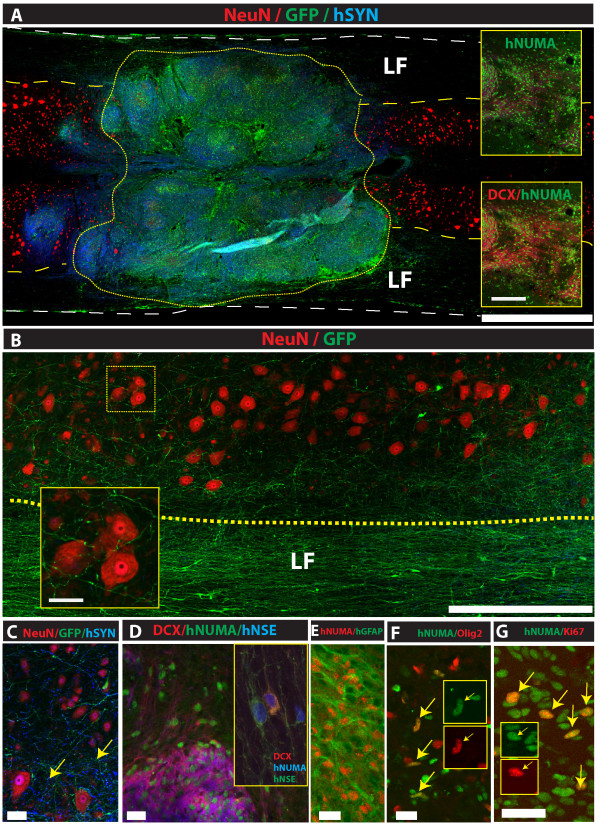
Survival, differentiation and extensive axonal outgrowth from spinally grafted HSSC. A: Grafted GFP+ or hNUMA+ cells can be seen almost completely filling the lesion cavity at eight weeks after grafting (yellow dotted area; inserts). B: Detail from ‘A’ depicting a dense GFP+ neurite network in the lateral funiculus (LF) and with numerous axons projecting towards α-motoneurons and interneurons in the gray matter (insert). C: In areas with a dense GFP+ axodendritic network, clear hSYN immunoreactivity associated with GFP+ processes can be detected (yellow arrows). D: The majority of grafted hNUMA+ cells showed development of the neuronal hNSE/DCX+ phenotype. E, F: A subpopulation of grafted hNUMA+ cells showed the astrocyte (hGFAP+) and oligodendrocyte (Olig 2) phenotype (F; yellow arrows). G: Using mitotic marker Ki67, regularly distributed hNUMA/Ki67+ grafted cells were identified (yellow arrows). (Scale Bars: A: 1.5 mm (inserts: 200 μm); B: 600 μm (insert: 75 μm); C: 60 μm; D: 20 μm; E-G: 10 μm). HSSC, human fetal spinal cord-derived neural stem cells; SCI, spinal cord injury.